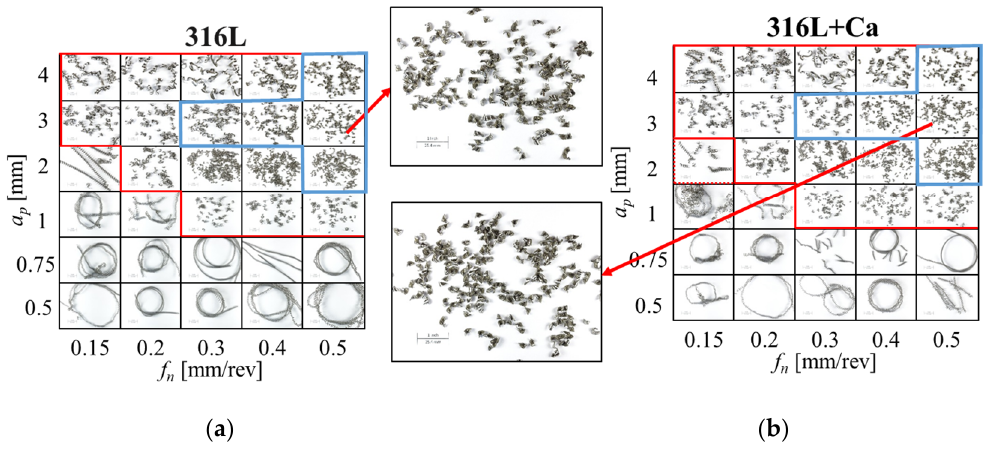
Figure 2. Chip charts of ( a ) the reference sample (316L) and ( b ) the experimental sample (316L + Ca) at a cutting speed of 130 m/min, reproduced from Ref. [16].